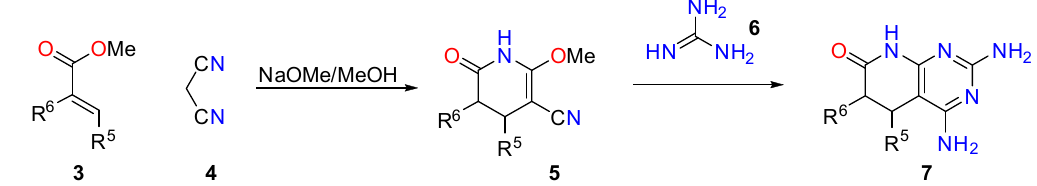
Figure 2. Synthesis of 2,4-diamino-5,6-dihydropyrido[2,3- d ]pyrimidin-7(8 H )-ones ( 7 ) from 2-methoxy-6-oxo-1,4,5,6-tetrahydropyridine-3-carbonitriles ( 5 ).